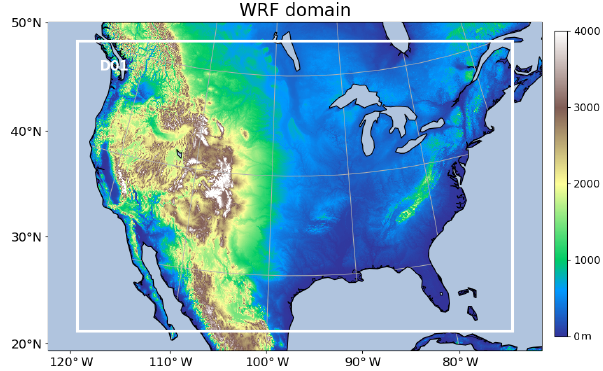
Figure 1. Domain and terrain height (m) of the WRF-Chem simula- tion with 350 × 290 grid cells and a horizontal resolution of